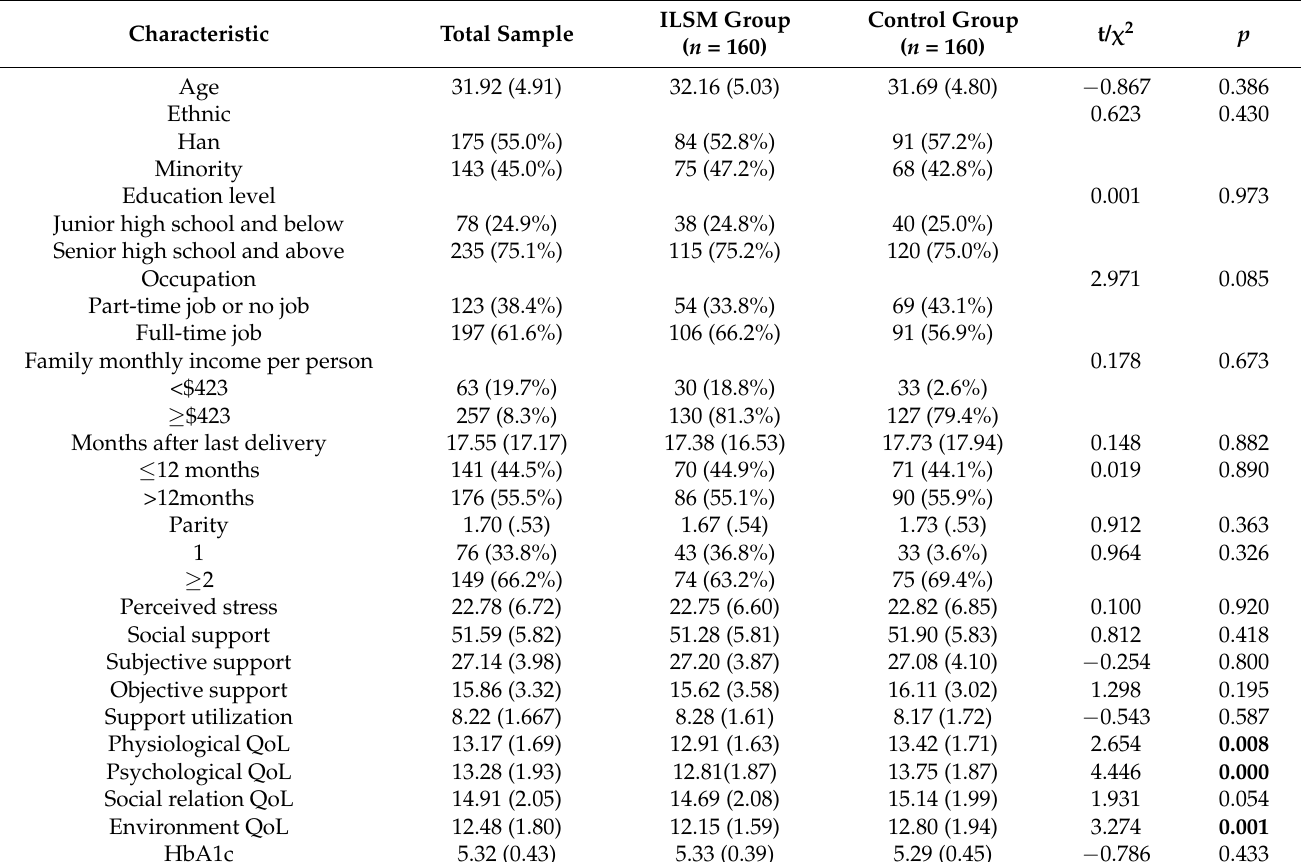
Table 1. Baseline characteristics of women with gestational diabetes mellitus (GDM) by the randomization condition.